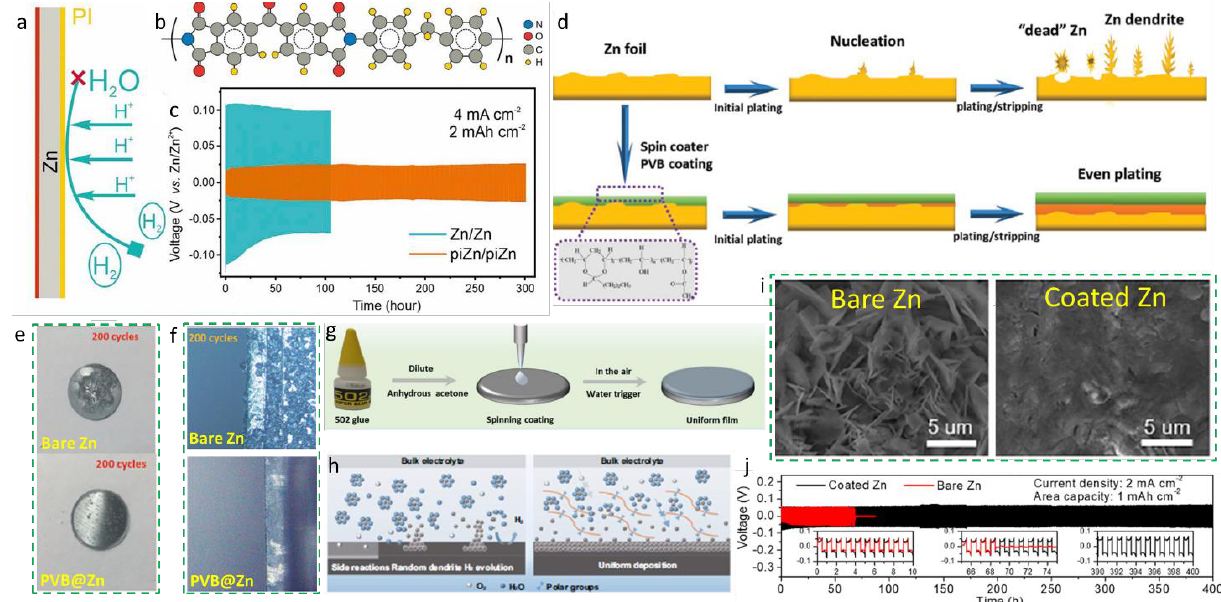
Figure 9. ( a ) Mechanism of anti-corrosion providing by polyimide layer, ( b ) structure of polyimide, ( c ) long-term galvanostatic cycling of symmetrical cells with bare Zn and polyimide-Zn anode at a current density of 4 mA cm − 2 and capacity of 2 mAh cm − 2 (Reproduced with permission. [46] Copyright 2021, John Wiley & Son). ( d ) Schematic illustration of the morphological evolution of a bare Zn and PVB@Zn symmetrical cell during stripping/plating cycles, ( e ) images of electrodes stripped out of cells after 100 cycles of Zn and PVB@Zn, and ( f ) in situ optical microscope images of Zn electrodes and PVB@Zn electrodes in symmetric transparent cells, along with the specified plating/stripping cycles. (Reproduced with permission. [60] Copyright 2020, John Wiley & Son). ( g ) Schematic diagram of a preparation of cyanoacrylate adhesive (502-glue) coating on Zn foil, ( h ) schematic diagram of the mechanism of 502-glue for suppressing Zn dendrite, ( i ) cycling stability for symmetrical cells of bare Zn and 502-Zn at 2 mA cm −2 for 1 mAh cm −2 , and ( j ) morphology of bare zinc foil (left) and 502-decorated Zn foil (right) obtained from symmetric Zn cells after zinc stripping/plating for 100 cycles at 0.5 mA cm −2 for 0.25 mAh cm −2 . (Reproduced with permission. [109] Copyright 2021, Elsevier).